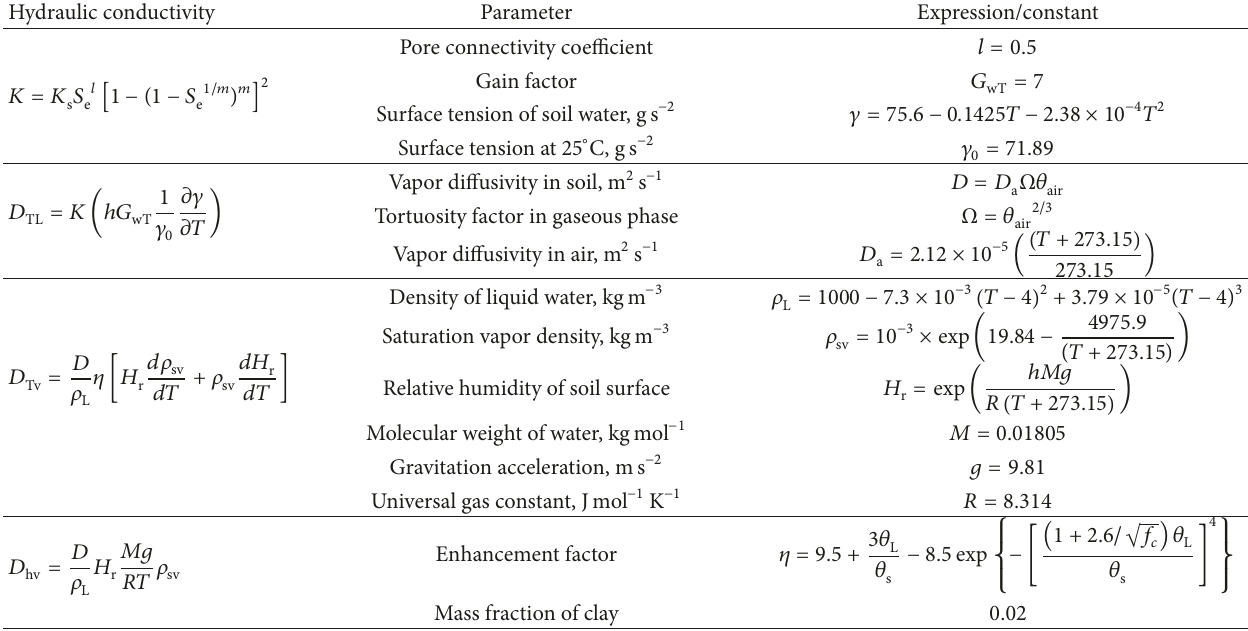
Table 1: Hydraulic conductivities for liquid-water and water vapor flux and related parameters.